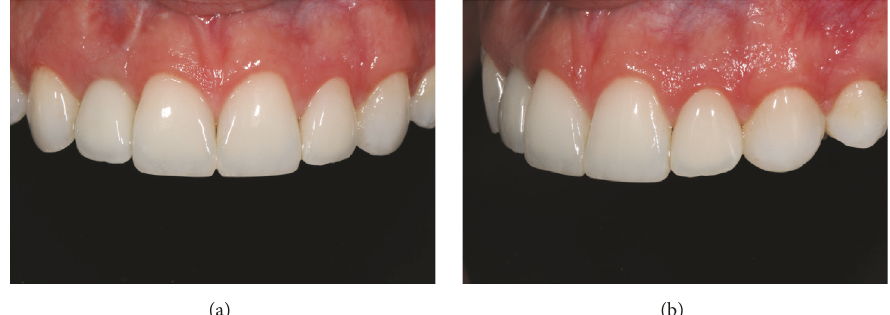
Figure 9: Front (a) and left (b) detail of resin restorations combined with ceramics.